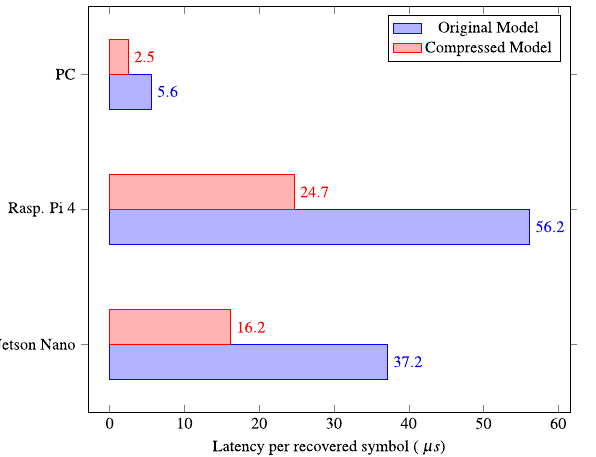
Figure 5. Summary of the symbol processing (inference) time for the compressed NN models (after pruning and quantization) and the original models for three devices under evaluation: a Raspberry Pi 4, a Nvidia Jetson Nano, and a standard